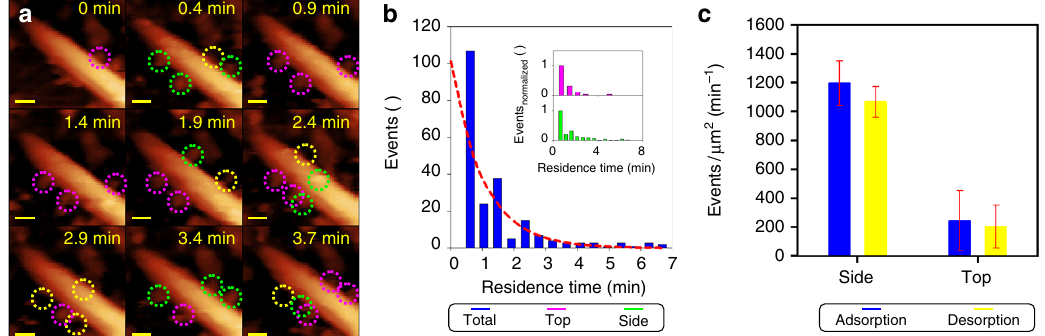
Fig. 2 Adsorption/desorption of LPMO. a Real-time observation of C1 oxidizing LPMO molecules adsorbing to and desorbing from cellulose nanocrystals. Images are taken from Supplementary Movies 3 and 4. Colored frames show enzymes present initially (magenta), adsorbing (green), or desorbing (vacated position; yellow) in the relevant timespan. b The residence time of LPMO on the surface of nanocrystals. The histogram was fi tted by an error weighted exponential decay function (shown in red), yielding a dissociation rate constant of 0.97 min − 1 . Qualitative analysis showed similar distributions for LPMOs independent of their adsorption site. c Adsorption and desorption events on the top and side surfaces of cellulose nanocrystals revealed by analyzing ~ 220 individual enzymes bound to 8 different nanocrystals. Mean values of events/surface area of cellulose nanocrystal are shown together with the corresponding standard error. Scale bars are 10 nm